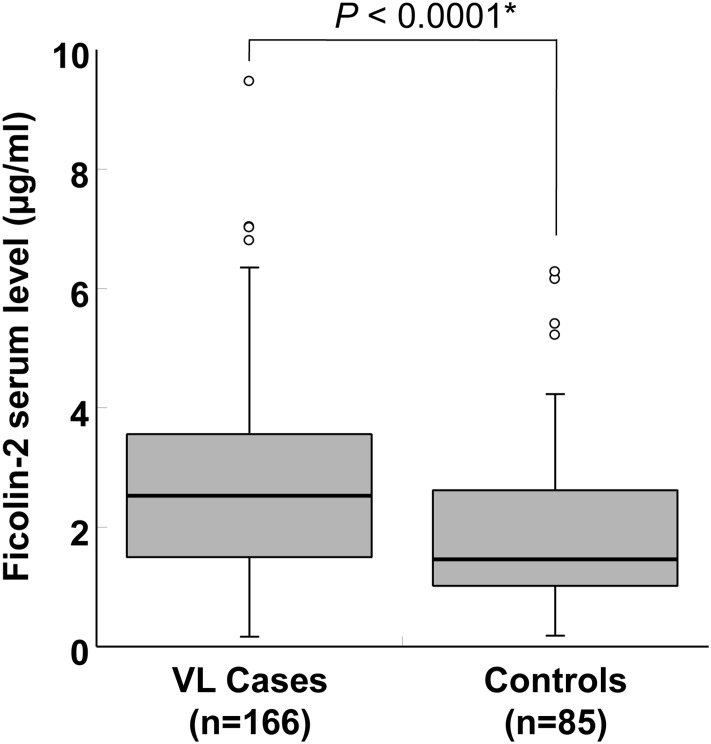
Distribution of ficolin-2 serum levels in visceral leishmaniasis cases and healthy controls.Box-plots illustrate medians with 25 and 75 percentiles with whiskers to 10 and 90 percentiles. *P values were calculated by multivariate analysis adjusted for age, gender and ethnicity. Numbers in parenthesis represent the number of samples.